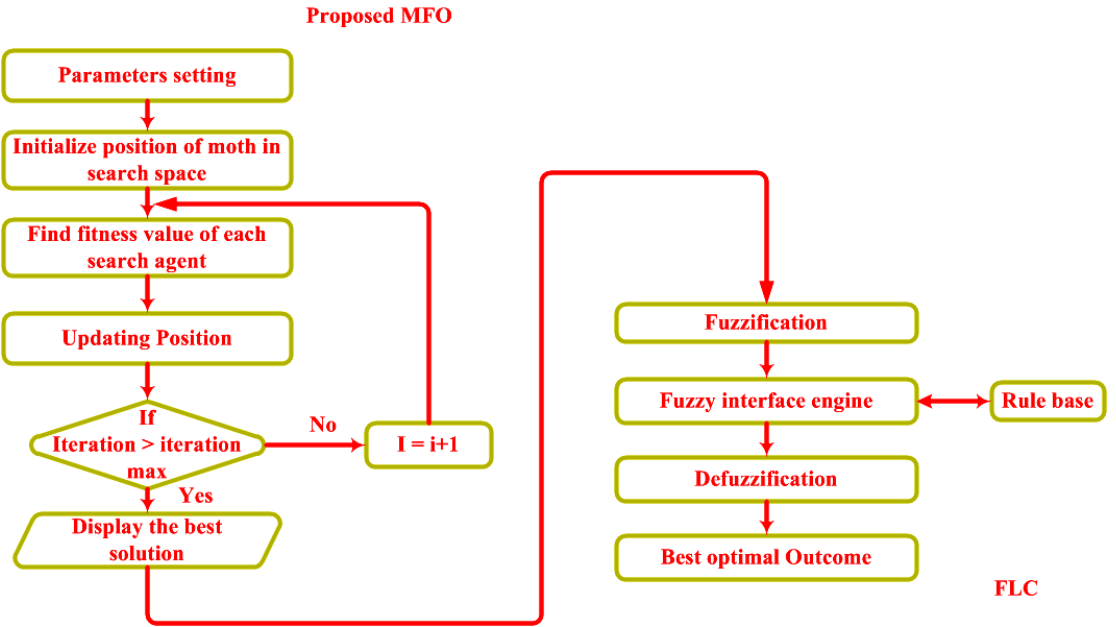
Figure 4. Flow chart of proposed MFFLC method.